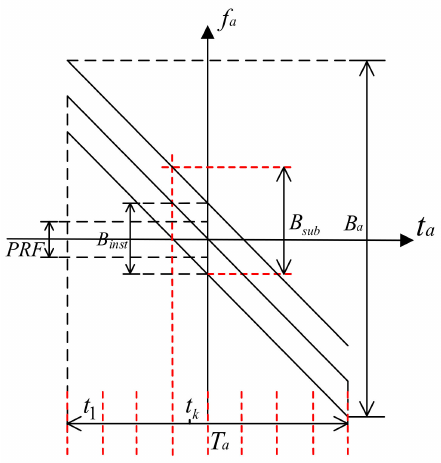
Figure 2. Time frequency diagram of a single equivalent phase